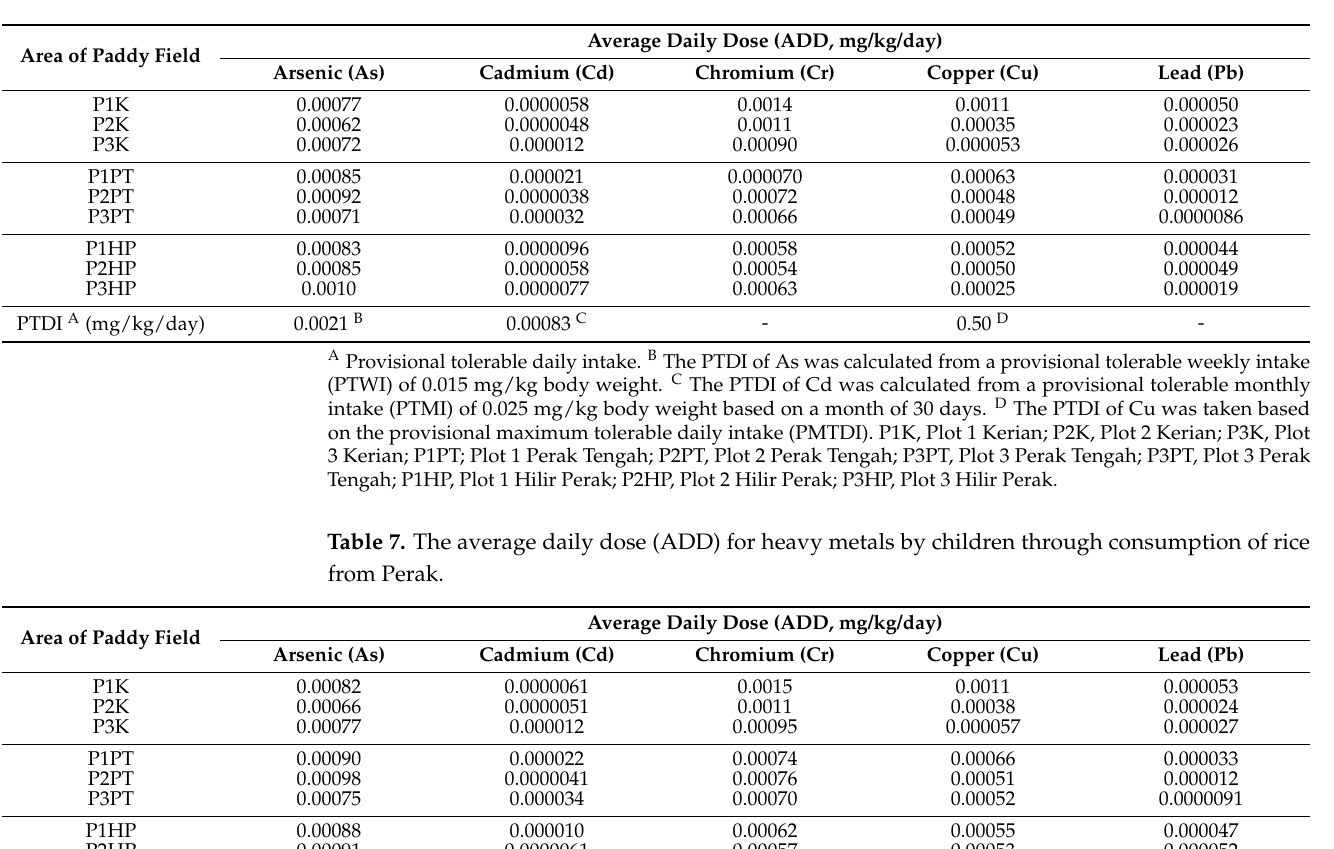
Table 6. The average daily dose (ADD) for heavy metals by adults through consumption of rice from Perak.